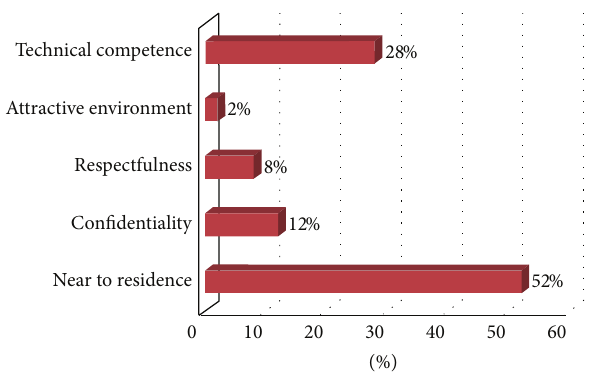
Figure 4: Reason of preference for VCT providing sites BDU, April